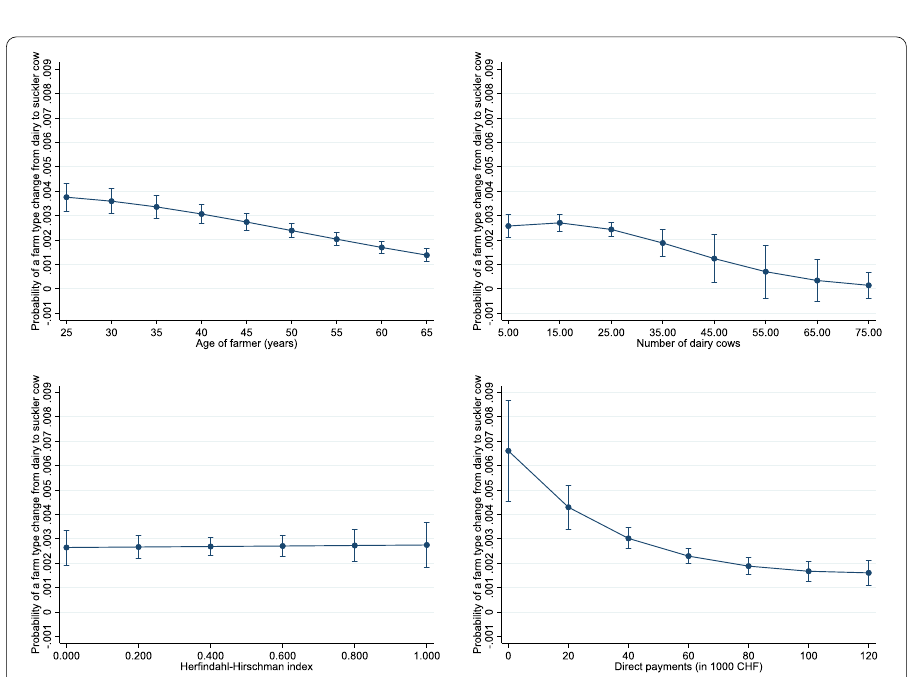
Fig. 8 Predicted probabilities for a farm type change from dairy to suckler cow. Notes : Predictions with 95% confidence interval